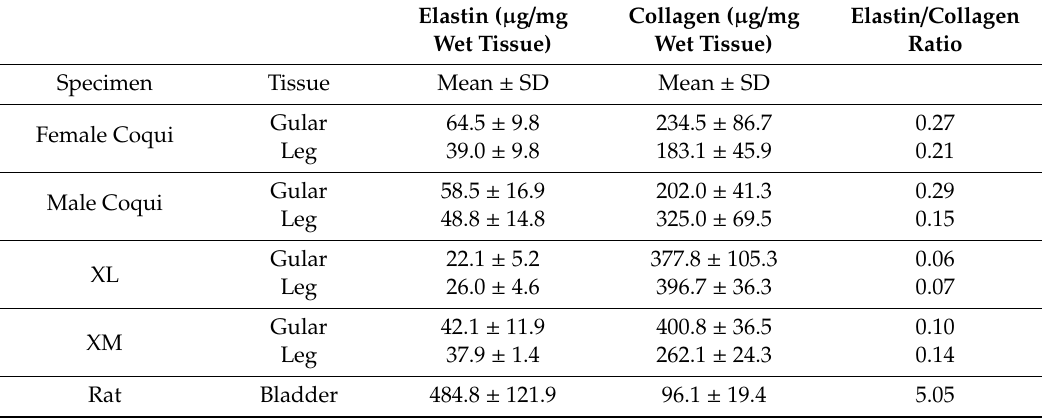
Figure 7. ( A ) Elastin content and ( B ) collagen content for the respective tissue sample. M: male, Figure 7. ( a ) Elastin content and ( b ) collagen content for the respective tissue sample. M: male, F: F: female. p < 0.05 (*) and p < 0.01 (**). female. p < 0.05 (*) and p < 0.01 (**). Table 2. Summary of elastin and collagen content in tissue Table 2. Summary of elastin and collagen content in tissue samples.